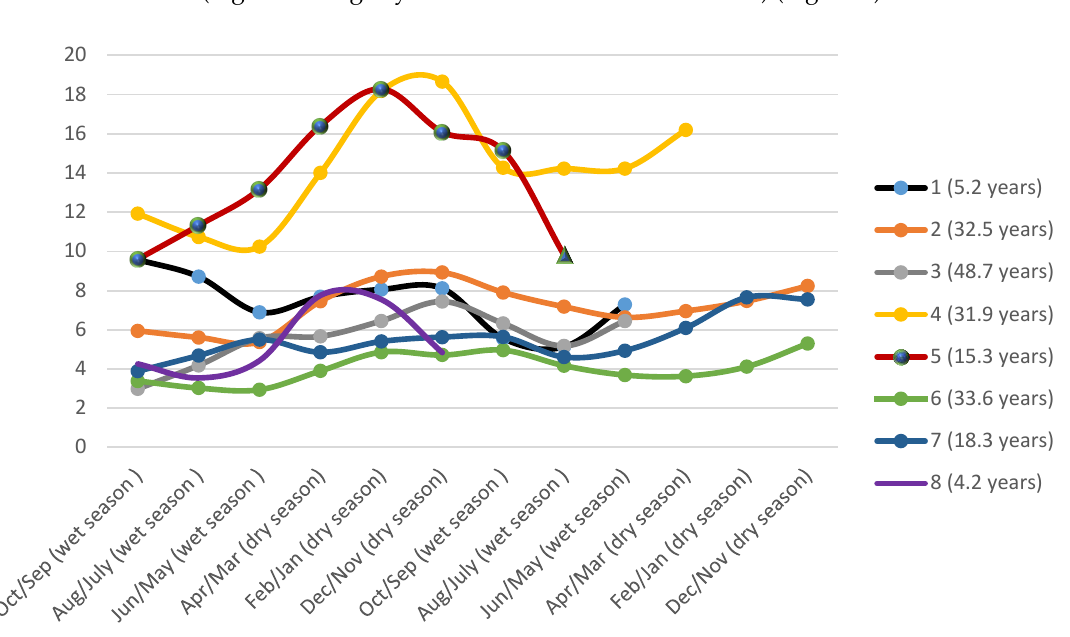
Figure 4. Sequential Hg concentrations (μg·g −1 ), 2 cm of hair segments from each individual, of 8 women from Waikás-Ye’kuana village, Yanomami Reserve, Roraima, Amazon, Brazil, 2014.